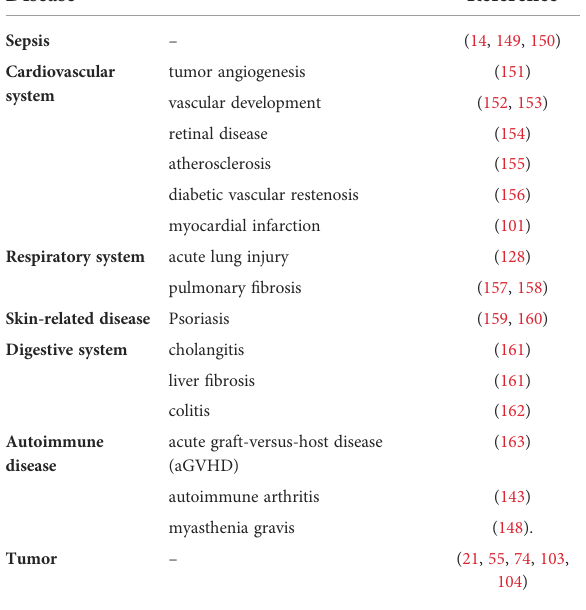
TABLE 2 Immune-related diseases.